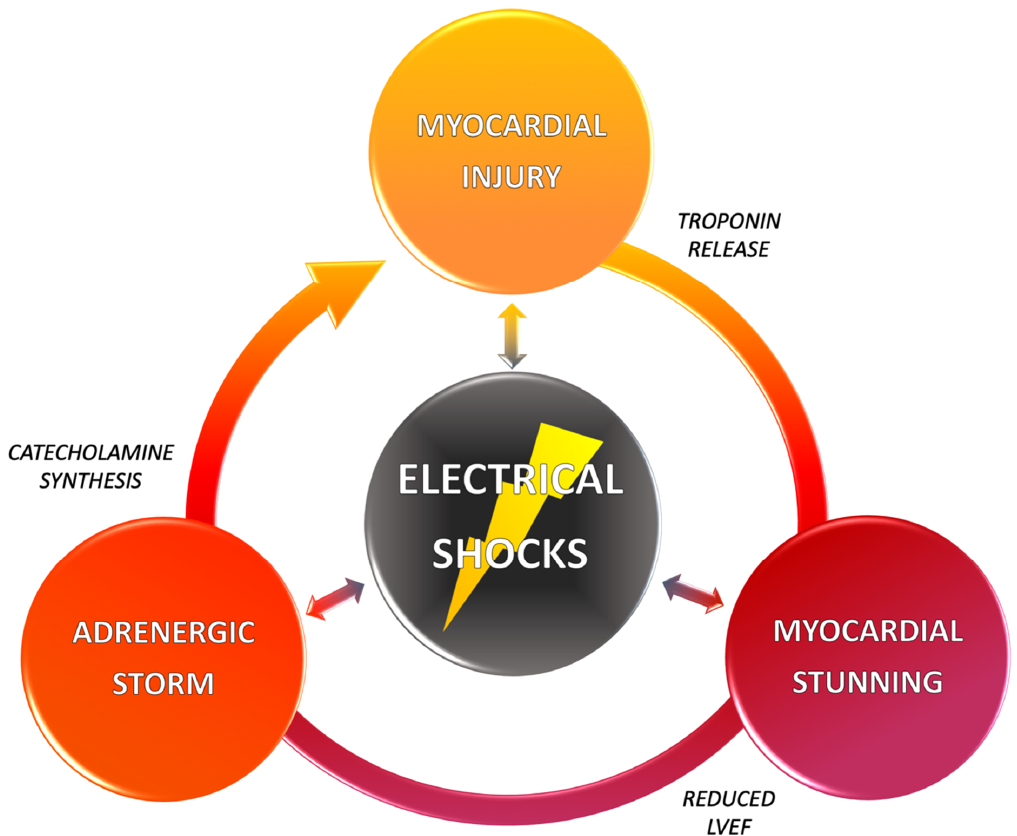
Figure 2. The vicious circle of ICD shocks. High-energy shocks induce myocardial injury, as shown by elevated troponin serum levels. They also induce myocardial stunning, and subsequent reduced left ventricular ejection fraction (LVEF) and cardiac output. They finally induce directly and through acute heart failure a major catecholamines release, with proarrhythmic effects, which increases the risk of arrhythmia reinduction and ICD shocks.